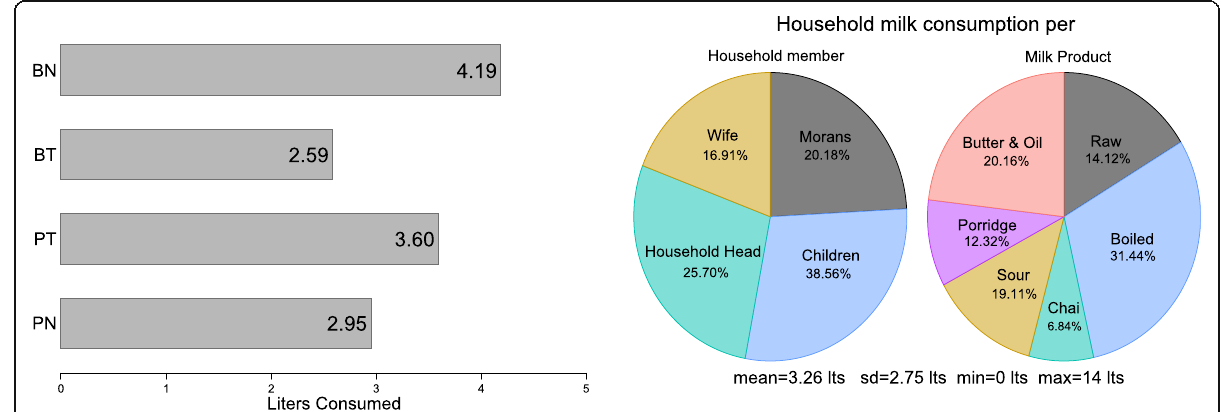
Fig. 4 Pre-intervention dairy consumption patterns across Maasai villages ( N = 4), households ( N = 124), and dairy products. Litres of milk consumed within each intervention village, including boiling-narrative (BN), boiling-technical (BT), pasteurization-technical (PT), and pasteurization- narrative (PN) (left panel). Demographics and dairy products consumed (right